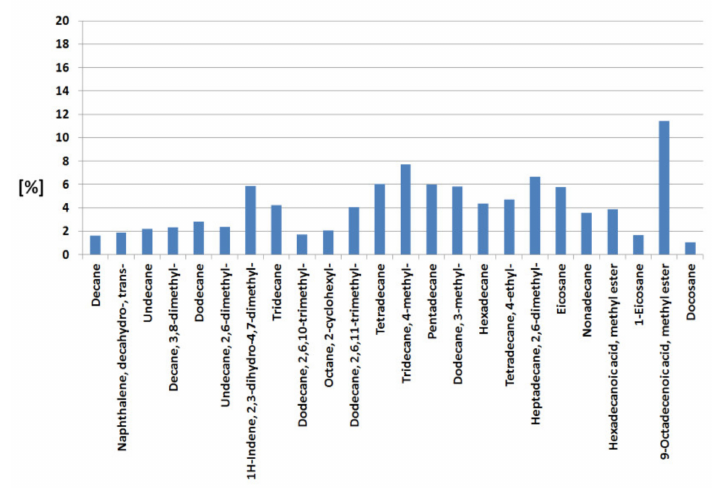
Figure 4. Chemical content of diesel with addition of 6% of methyl ester of brown grease MEBG (goose fat methyl ester).